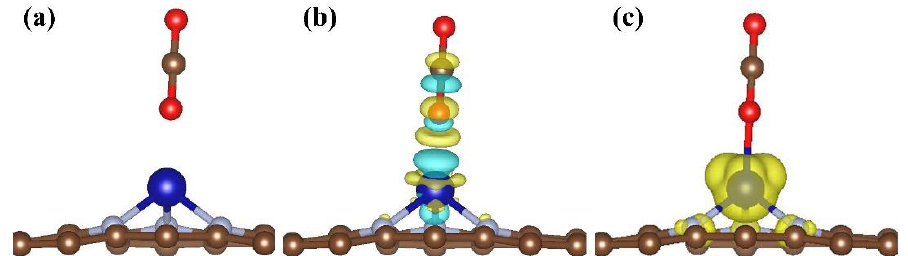
Figure 5. ( a ) The adsorption configuration of CO 2 on Co/N 3 –gra; ( b ) The charge density difference of Co/N 3 –gra with CO 2 adsorbed on it. The yellow and blue areas indicate the accumulation and depletion of charge respectively, isosurface value: 0.002 e/Bohr 3 . ( c ) The spin density ( ∆ ρ = ∆ ρ ↑ − ∆ ρ ↓ ) of Co/N 3 –gra with CO 2 adsorbed on it. The yellow and blue areas indicate the positive and negative spin density respectively, isosurface value: 0.005 e/Bohr 3 .